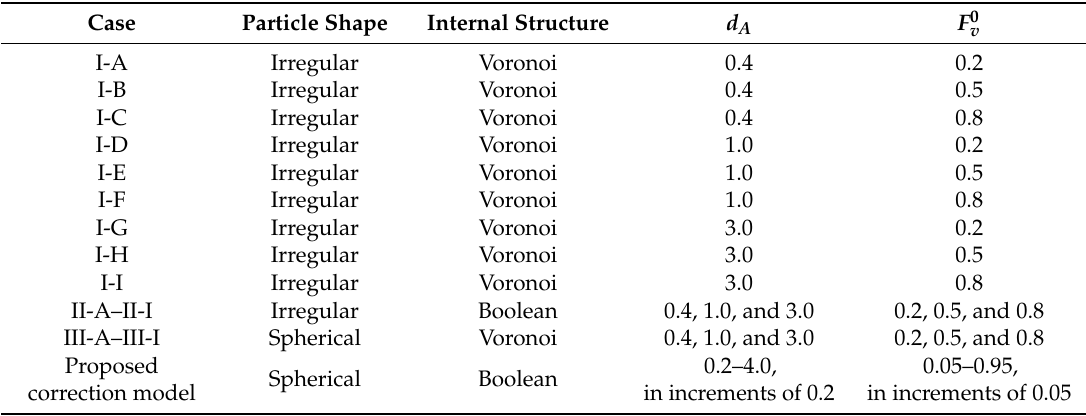
Table 1. Model validation